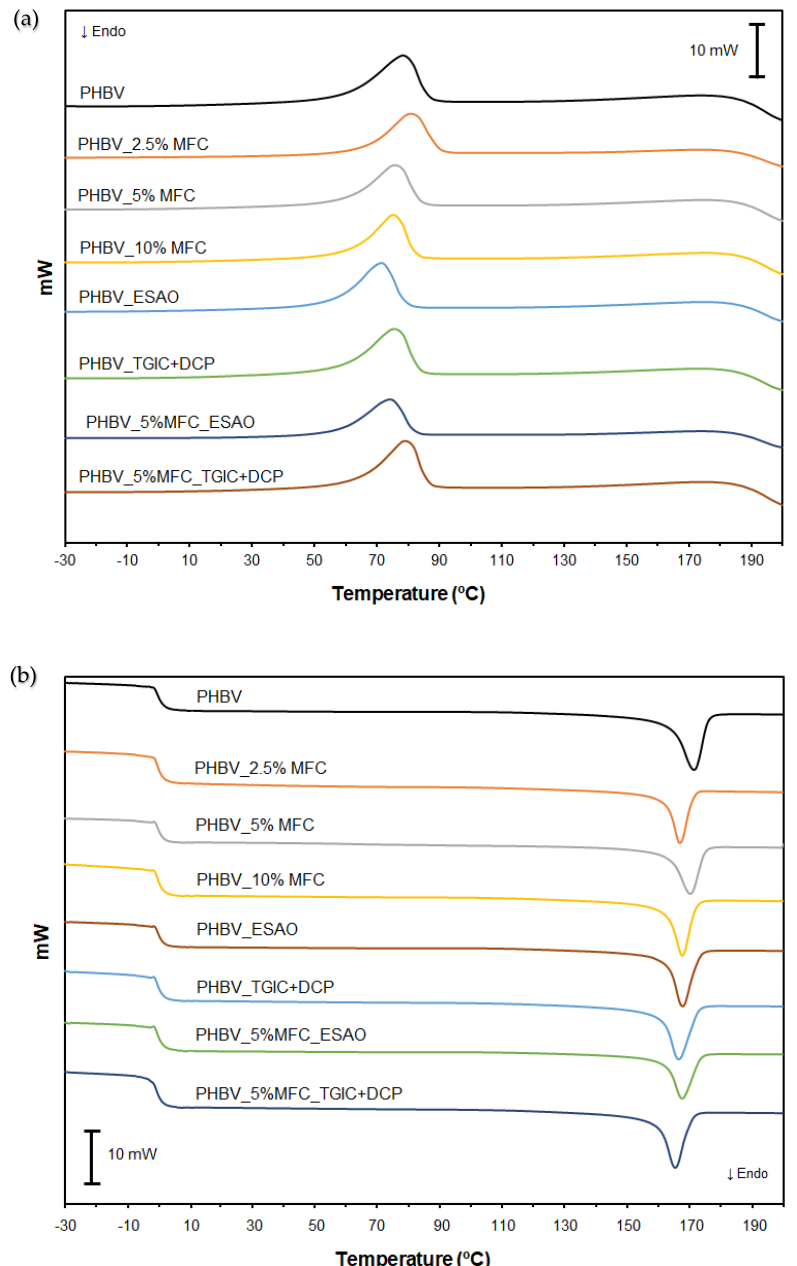
Figure 9. Differential scanning calorimetry (DSC) thermograms of the films of poly(3-hydroxybutyrate- co -3-hydroxyvalerate) (PHBV) with microfibrillated cellulose (MFC) and compatibilized with epoxy-based styrene-acrylic oligomer (ESAO) and with triglycidyl isocyanurate (TGIC) and dicumyl peroxide (DCP) as follows: ( a ) Cooling; ( b ) Second heating.